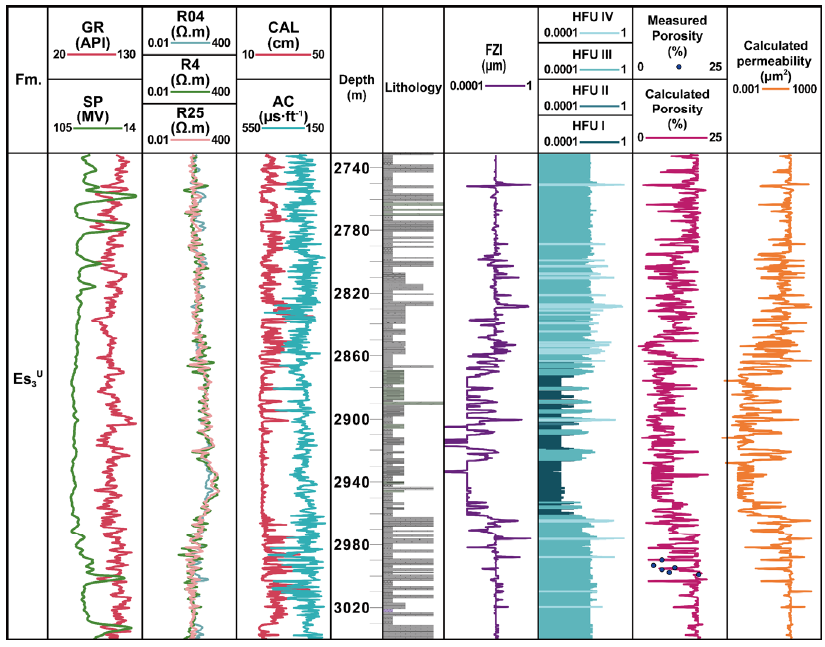
Figure 8. Calculated results of porosity and permeability of the shale reservoir.